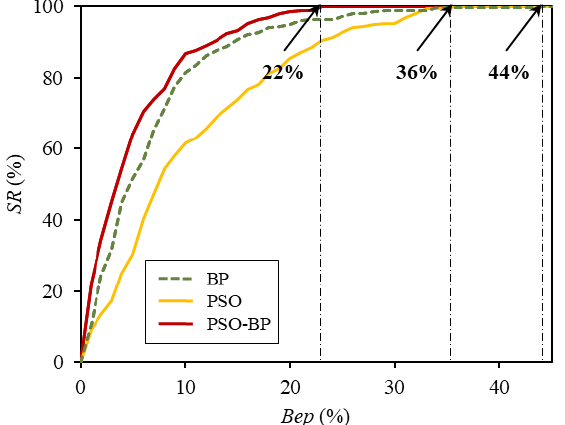
Figure 6. Comparison between the experimental CS and that predicted by the PSO-BP neural network.